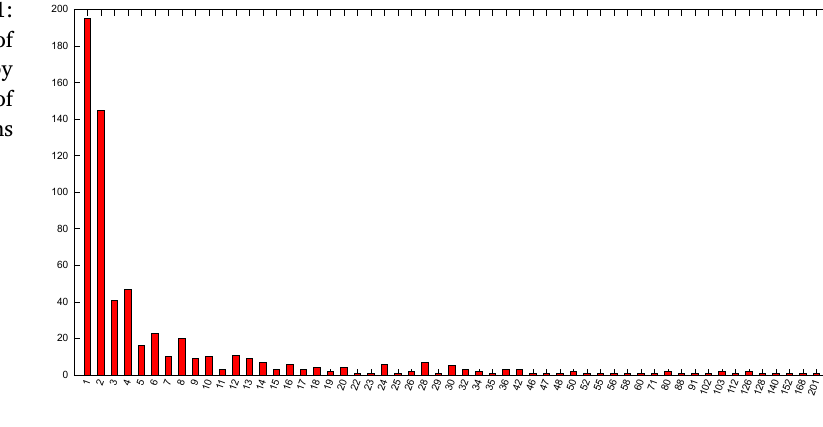
Figure 21: Frequency of sentences by number of